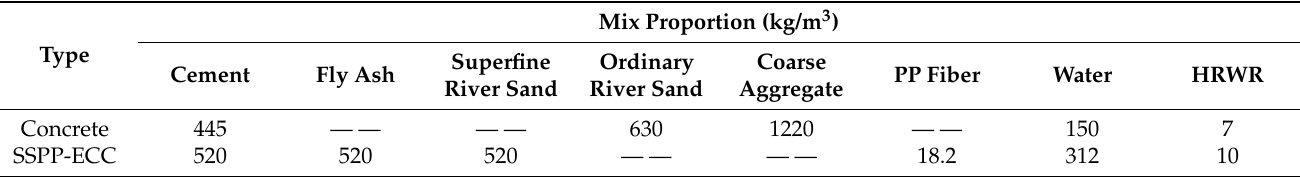
Table 3. Mix proportions of SSPP-ECC and